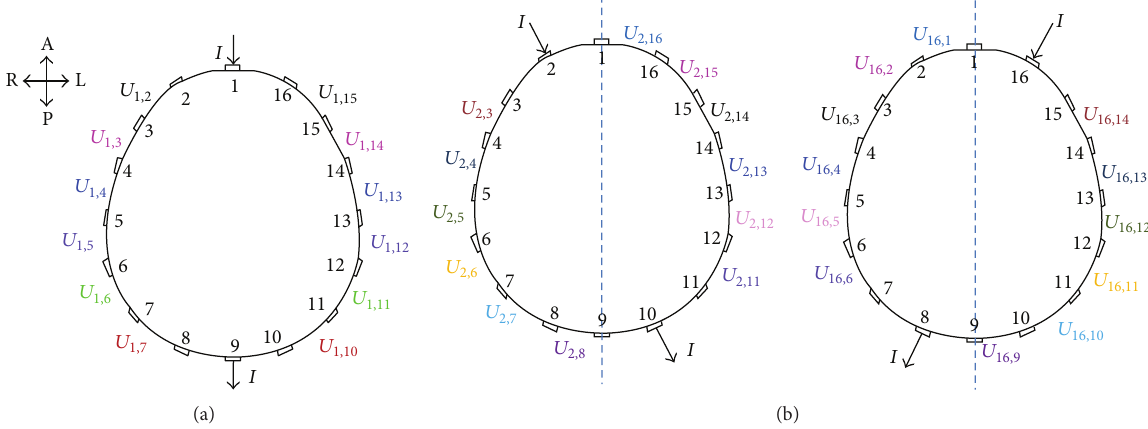
Figure 1: Illustrations of SBVP formation. (a) When the current was injected through electrode pair (1, 9), six groups of SBVP were formed by six BVs measured from the electrodes on the right hemisphere of the head and six other BVs from the left hemisphere. (b) The drives on electrode pair (2, 10) and (16, 8) constructed a pair of symmetrical drives. Six groups of SBVP were formed by six BVs measured from the right hemisphere during the drive on electrode pair (2, 10) and six BVs from the left hemisphere during the drive on electrode pair (16, 8). Similarly, another six groups of SBVP were formed by six BVs from the right hemisphere during the drive on electrode pair (16, 8) and six BVs from the left hemisphere during the drive on electrode pair (2, 10). This pair of symmetrical drives generated 12 groups of SBVP. Two BVs that formed one group of SBVP are marked with the same color (A: anterior; P: posterior; L: left; and R: right).